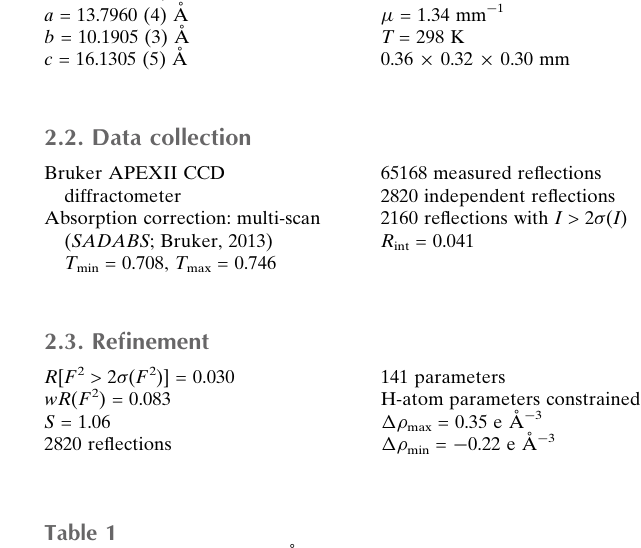
Hydrogen-bond geometry (A˚ , (cid:5)